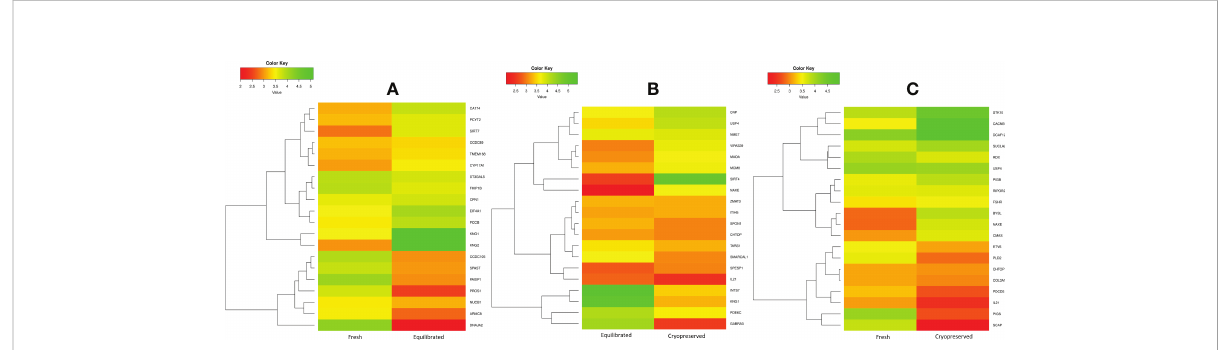
FIGURE 5 The heatmap of the top 10 abundantly differentially expressed proteins based on their expression intensities. (A) Differentially expressed proteins between fresh and equilibrated sperm, (B) differentially expressed proteins between equilibrated and cryopreserved sperm, and (C) differentially expressed proteins between fresh and cryopreserved